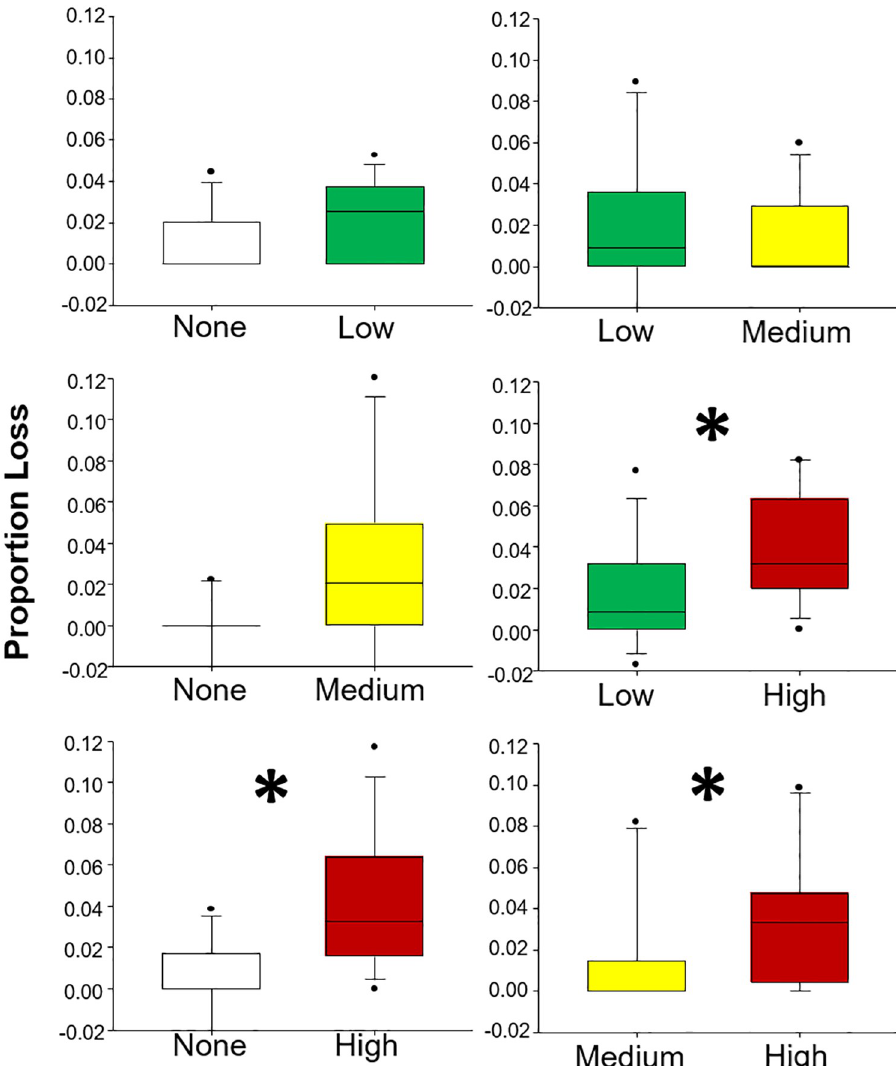
Fig 3. Results from Experiment 1: Amphipods. Paired choice experiments using amphipod ( G . mucronatus ) herbivores and plants grown in 4 oiled conditions: no (white), low (green), medium (yellow), and high (red). Asterisk indicates that a statistically significant difference